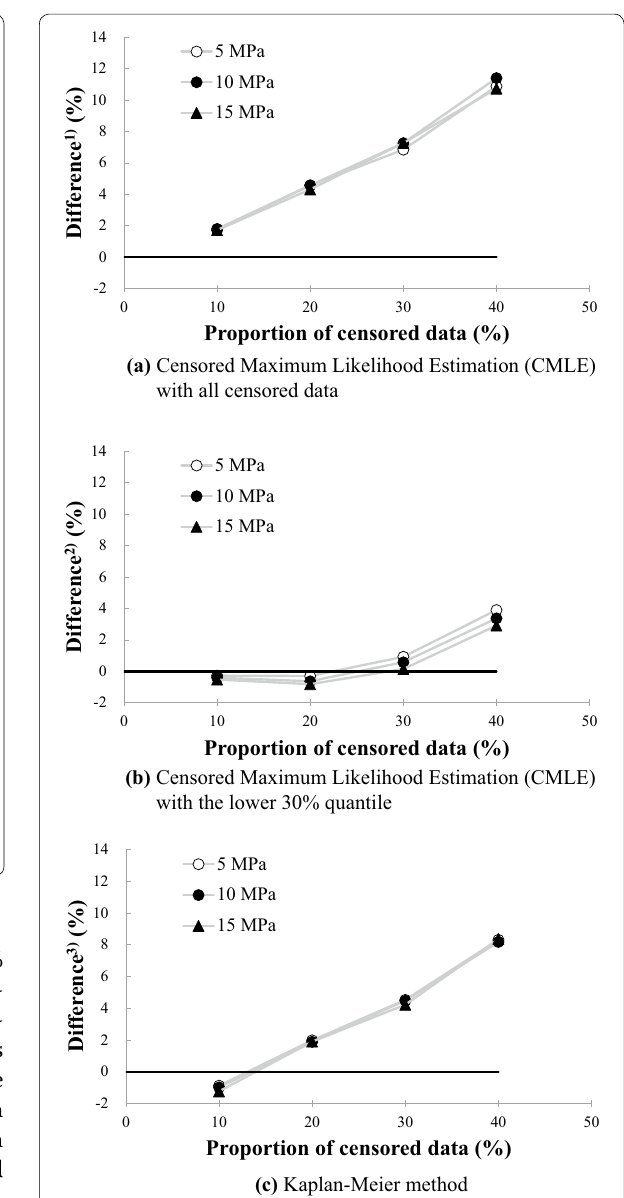
Fig. 4 Differences between 5th percentile values of censored datasets derived by censored data analysis and 5th percentile values of ideal datasets. a Censored maximum likelihood estimation (CMLE) with all censored data. b Censored maximum likelihood estimation (CMLE) with the lower 30% quantile. c Kaplan–Meier method. Difference 1 ) = 5% CD,CMLE_all − 5% ideal,MLE 5%